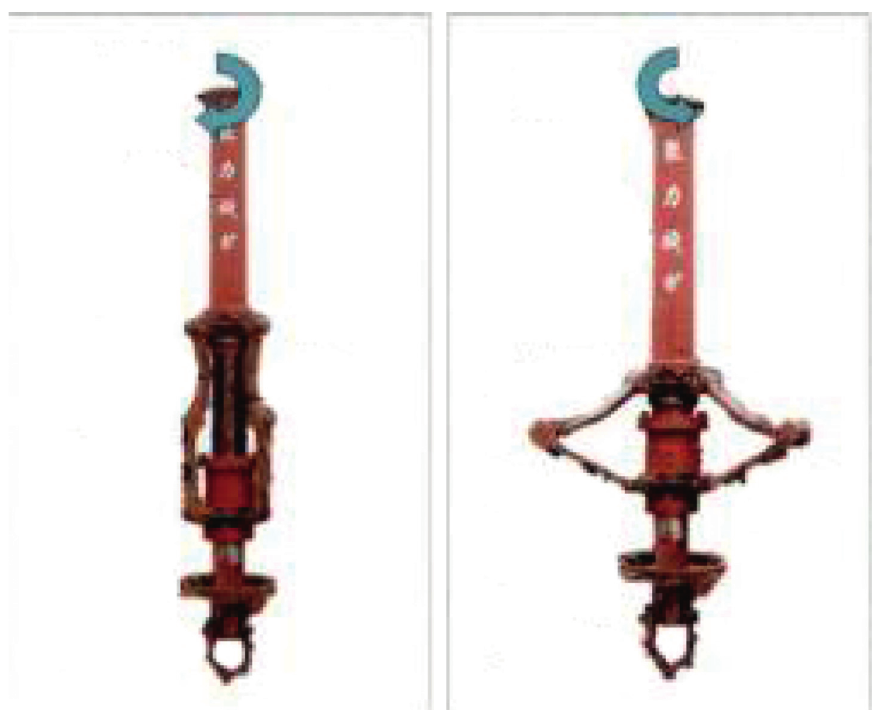
Figure 1: Expanding device of drilling, expanding, and cleaning all-in-one machine.